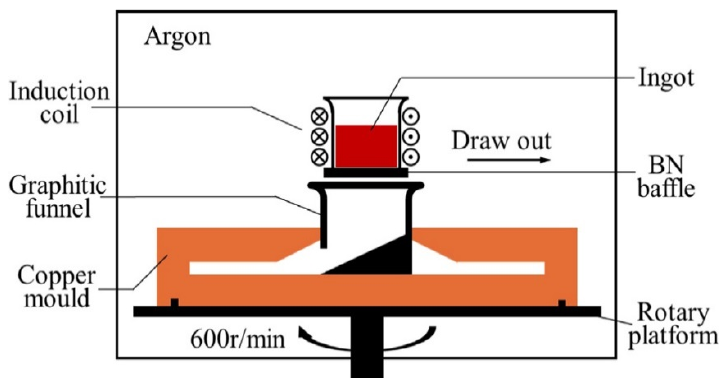
Figure 7. Schematic of centrifugal casting used for near-rapid solidification [84]. (Reprinted with permission from [84]. Copyright 2019 Elsevier).